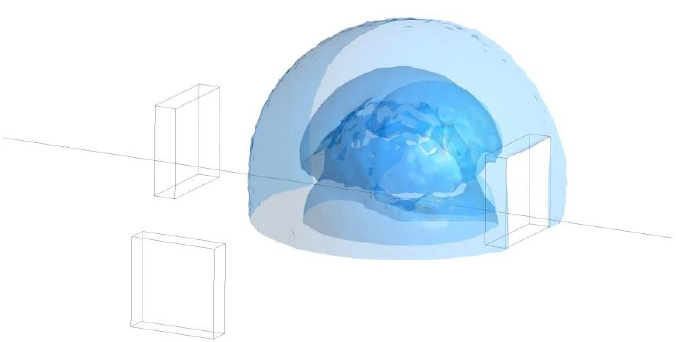
Figure 12. Display of isobaric surface with pressure 2 kPa in time of 5 ms.